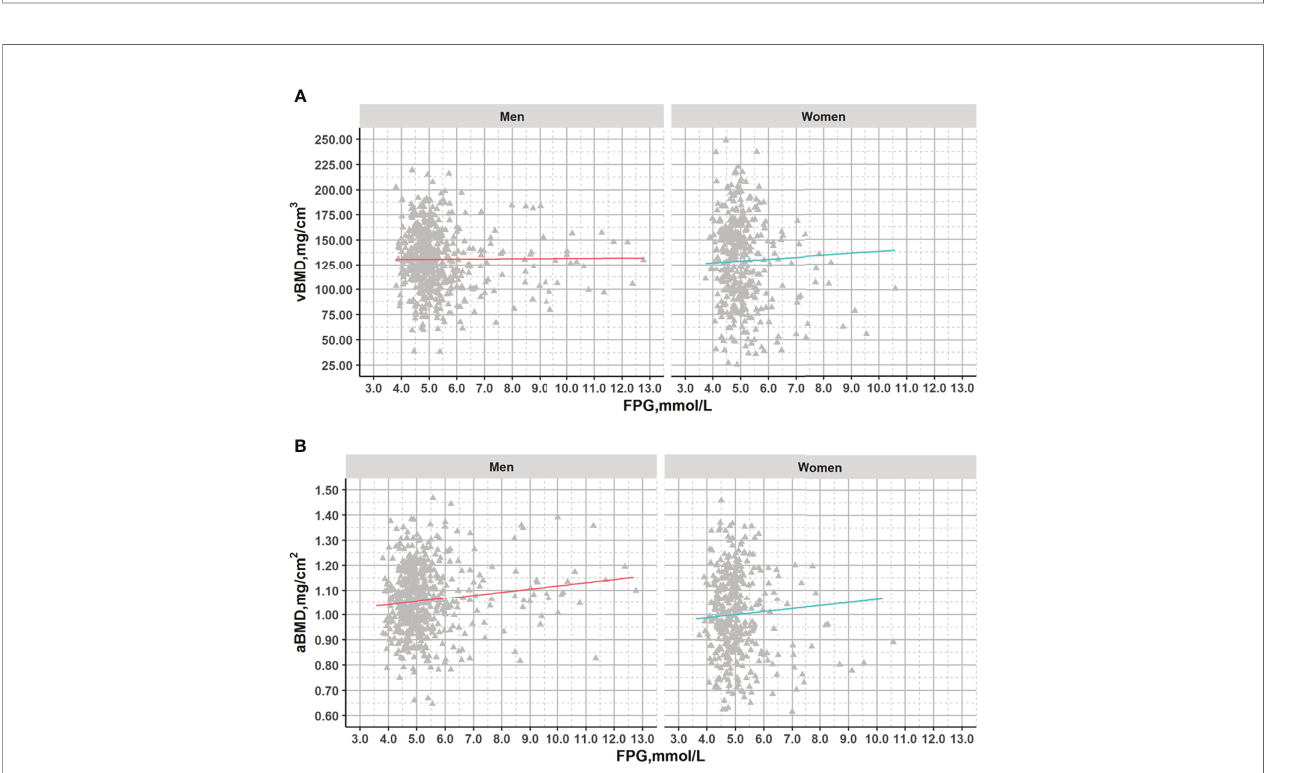
FIGURE 2 | Plots of vBMD and aBMD with fasting glucose across the range from normal to diabetes in DXA subcohort. Association lines (adjusted for age): (A) . Men: y=-0.190x+131.714, R 2 = 1.49*10 -4 , p=0.775; Women: y=1.964x+119.133,R 2 = 0.003,p=0.304; (B) . Men: y=0.009x+1.013, R 2 = 0.011,p=0.016; Women: